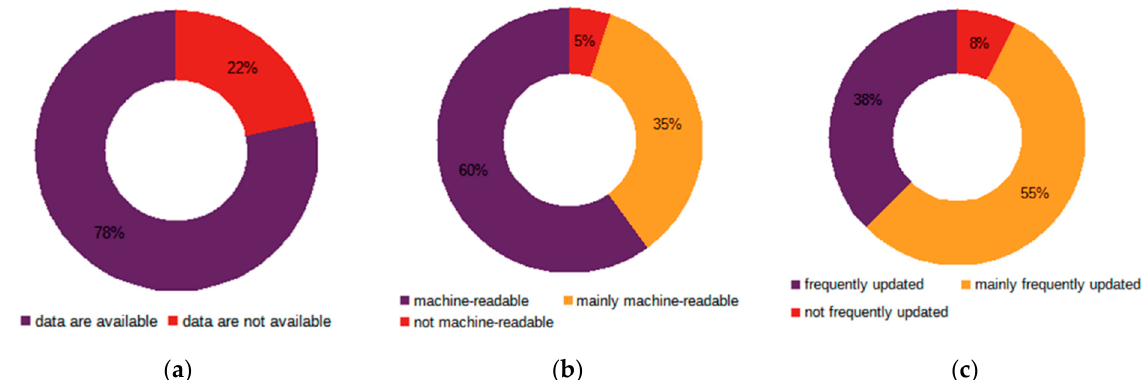
Figure 4. ( a ) COVID-19 data availability on the OGD portals; ( b ) COVID-19 data machine-readability; ( c ) COVID-19 data currency, i.e., frequency of updates.